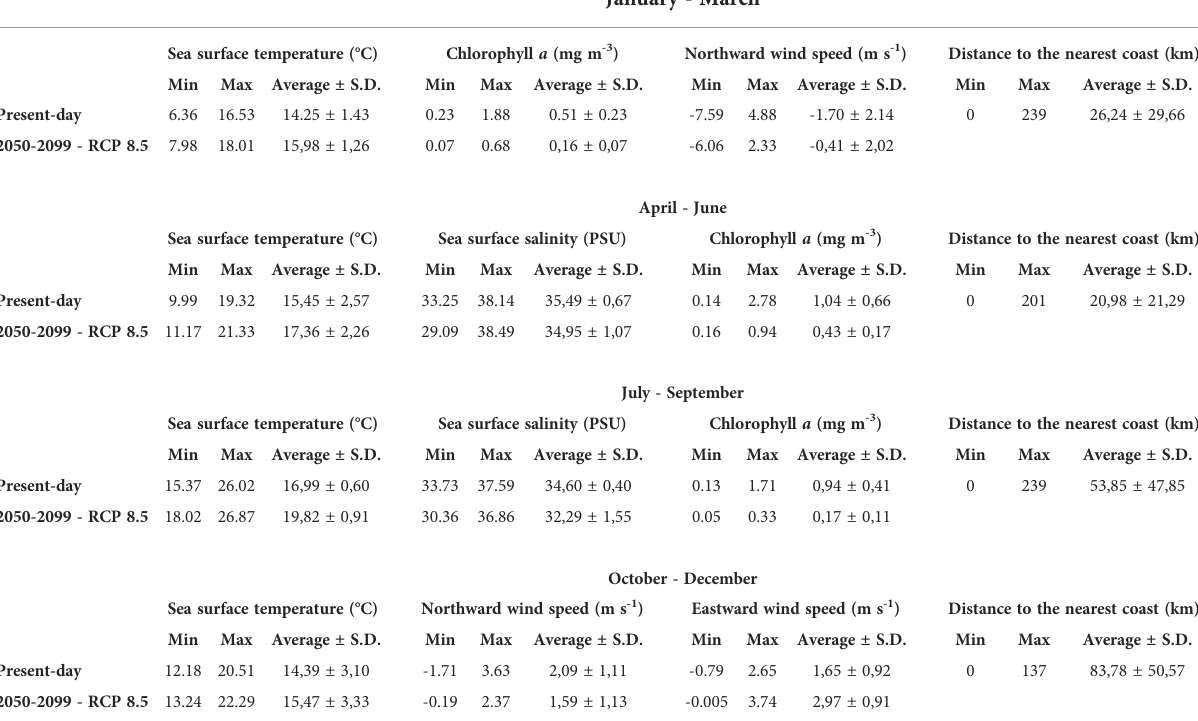
TABLE 2 Environmental conditions (averages from quarterly means) of present-day and future scenario for each season based on the occurrence